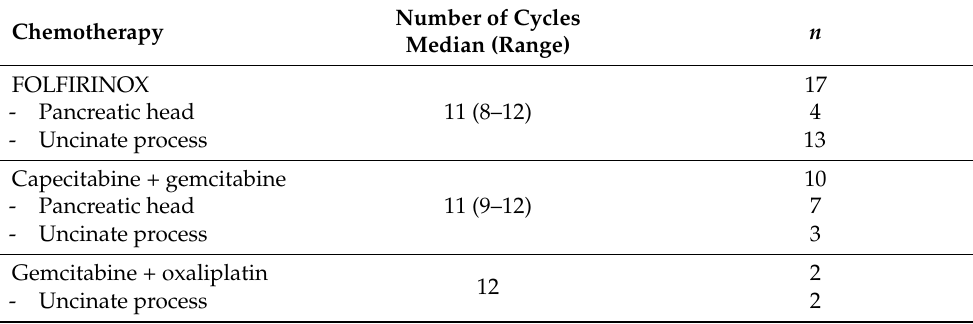
Table 1. Chemotherapy regimens for the study